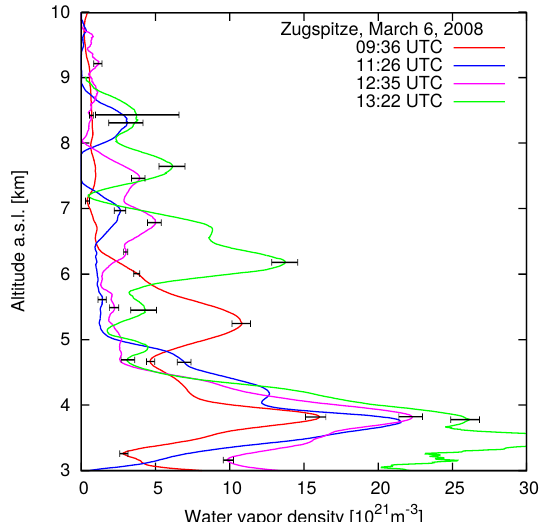
Figure 10. Example of extreme temporal variability of the vertical distribution of water vapor during a stratospheric intrusion event. Due to the advection velocity of about 11ms − 1 between 3 and 4km altitude (data from radiosonde at Munich at 12:00UTC, 100km to the north) a time shift of 1h corresponds to a horizontal shift of about 40km within this altitude range. The example error bars ( ± 2 σ ) represent statistical uncertainties caused by electronic noise in the detection.